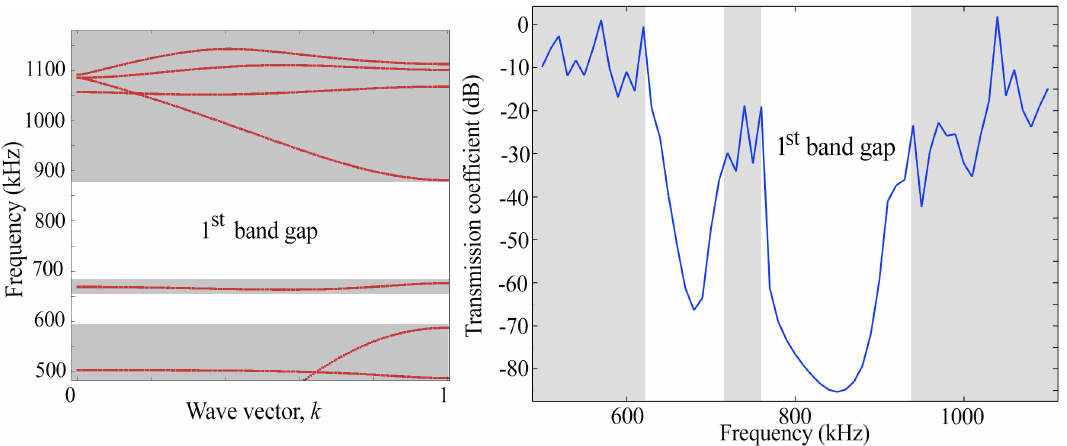
Figure 3. Dispersion and transmission coefficient for the band gap.